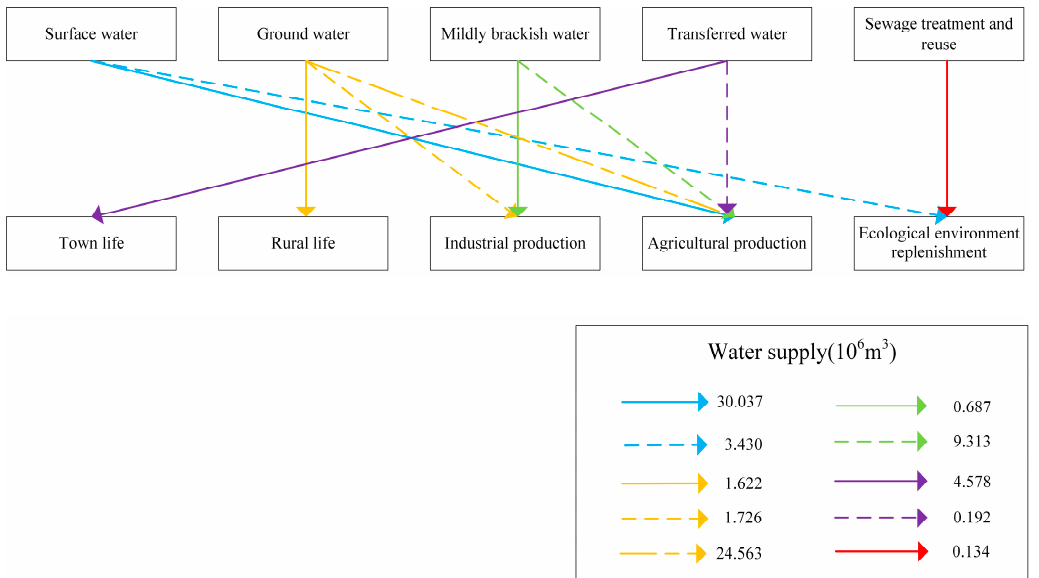
Figure 10. The relationship between water supply and demand between different water sources and different users in 2030 under the second scenario. Table 5. Water resources allocation results under different schemes (10 6 m³).